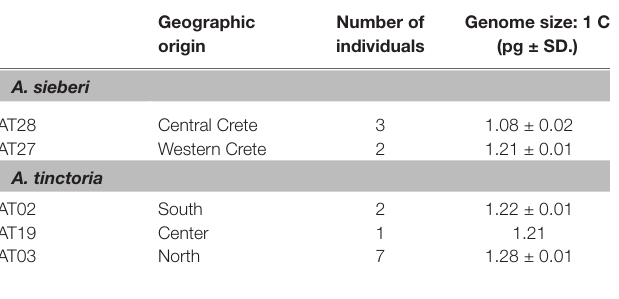
TABLE 1 | Genome size [average picogram (pg) ± standard deviation (SD)] of Greek Alkanna tinctoria and A. sieberi as measured by flow cytometry. Geographic origin